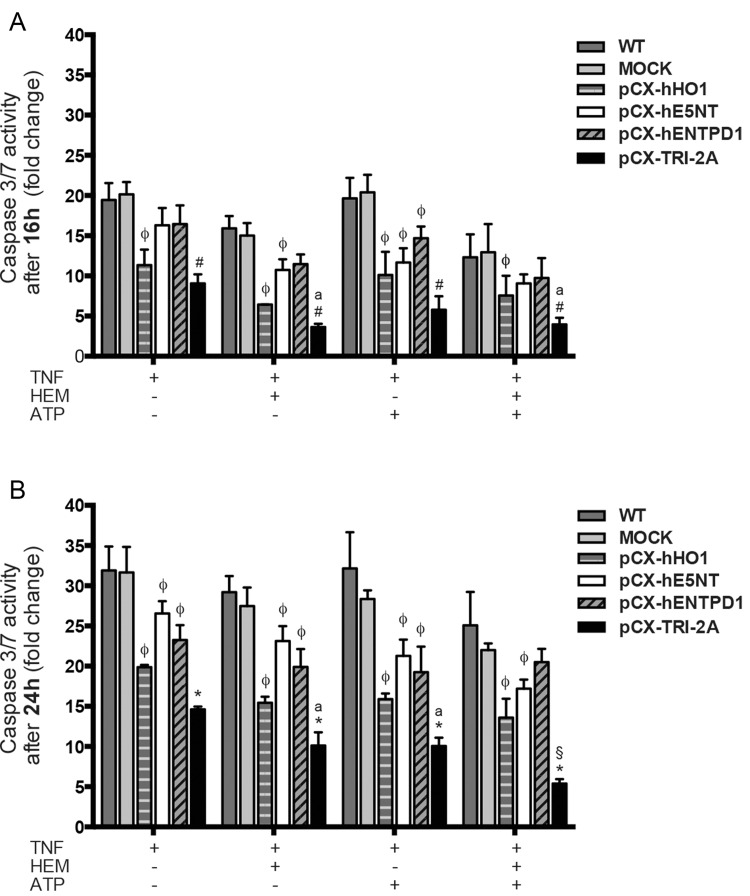
pCX-TRI-2A transfected-cells are protected against TNF-α-induced apoptosis.Caspase 3/7 activities were determined in all cell groups after 16h (A) or 24h (B) of incubation with 50 ng/ml TNF-α alone or in combination with 20 μM hemin and/or 200 μM ATP. Expression of the three human genes in TG cells significantly reduced the activation of effector caspases 3/7. The data are expressed as mean ± SD of three independent experiments. [#] indicates significant difference between pCX-TRI-2A and all the other groups, except for pCX-hHO1, within the same treatment (ANOVA, p<0.05). [*] indicates significant difference between pCX-TRI-2A and all the other groups within the same treatment (ANOVA, p<0.05); [ϕ] indicates a significant difference between single gene-transfected cells and WT/mock within the same treatment (ANOVA, p<0.05); [a] indicates significant difference as compared to TNF-α treatment alone within the same cell type (ANOVA, p<0.05); [§] indicates a significant difference as compared to all the other treatments within the same cell type (ANOVA, p<0.05).